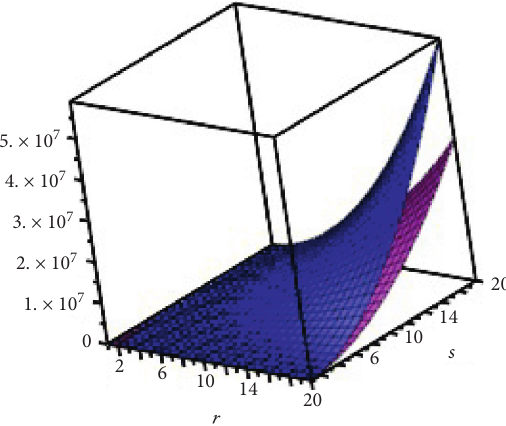
Figure 7: Comparison of R indices of M [ r, s, t ] for fix t � 1. Niagara azure, green, cyan, blue, purple, and red represents R − indices, respectively.